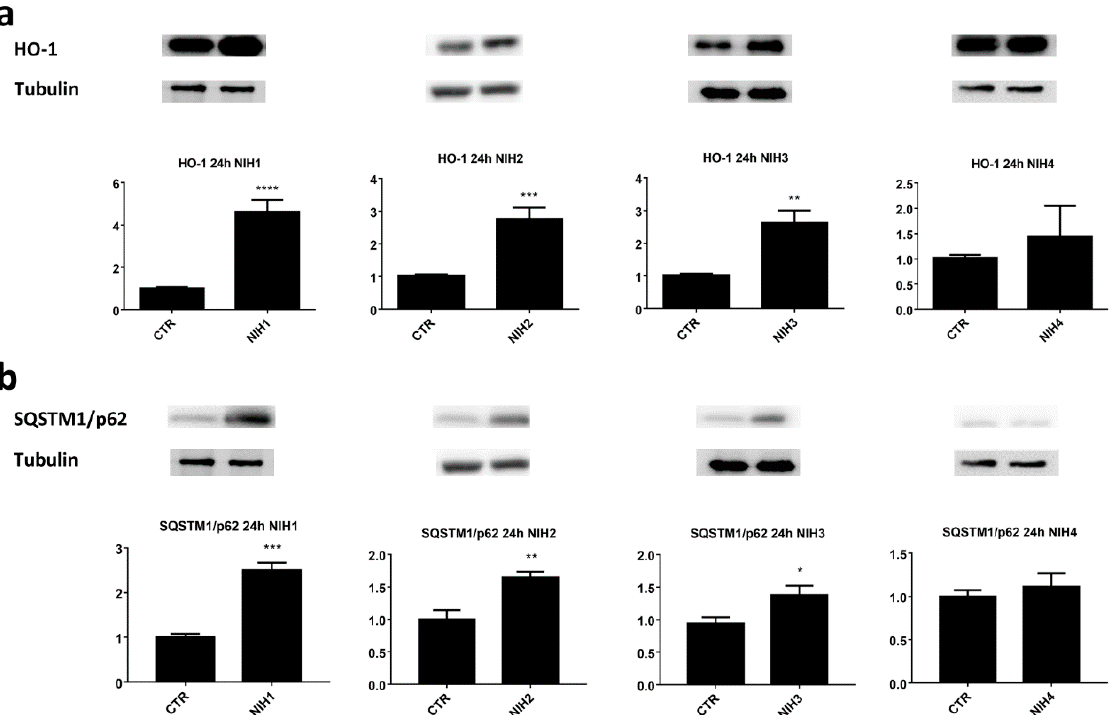
Figure 2. The effect of NIH compounds on the antioxidant defense system. ARPE-19 cells were treated with 5 µ M of NIH compounds for 24 h, and the protein levels of ( a ) HO-1 and ( b ) SQSTM1/p62 were analyzed via Western blotting. The protein bands were quantified and normalized against α -tubulin. The results are expressed as fold change of the means compared to control (CTR) ± S.E.M. n = 6 for each experiment; * p < 0.05; ** p < 0.01; *** p < 0.001; **** p < 0.0001, paired t - test.